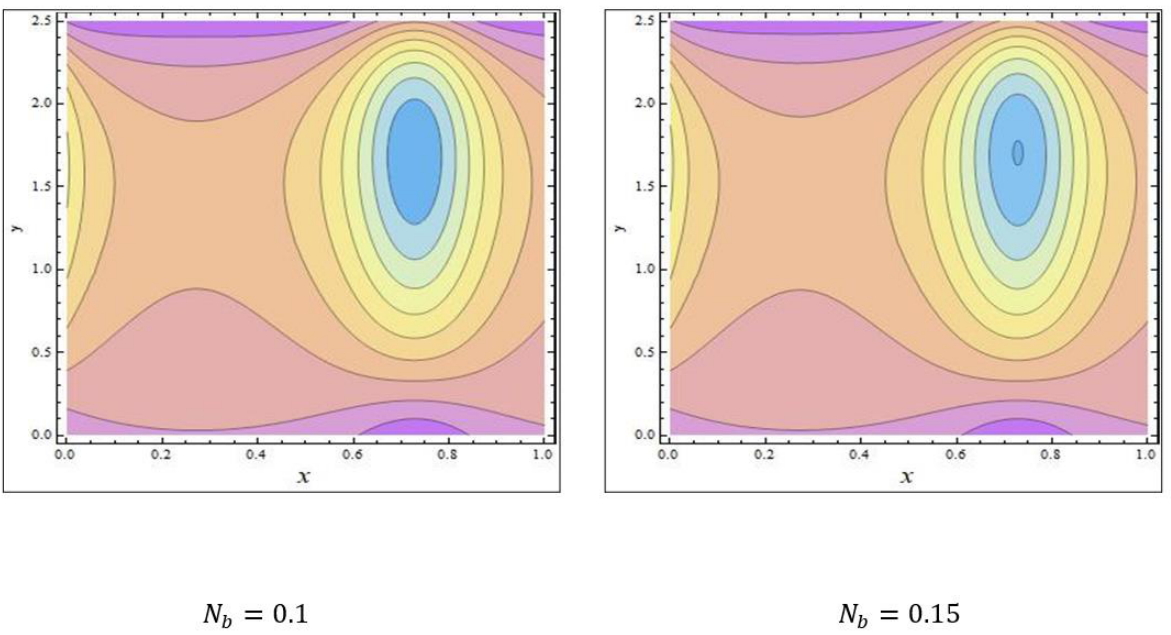
Figure 8. The streamlines of 𝑁 𝑏 . The values of the other parameters were 𝑁 𝐶𝑇 = 0.3, 𝑁 𝑇𝐶 = 0.7, 𝐺 𝑟𝑐 = 0.4, 𝐺 𝑟𝐹 = 0.1, 𝐺 𝑟𝑡 = 0.5, 𝑁 𝑡 = 0.7, 𝑀 = 3.5, 𝜙 = 𝜋 , 𝛤 = 0.8, 𝛽 = 0.7, 𝑚 = 0.6, 𝑄 = 2.37. 6